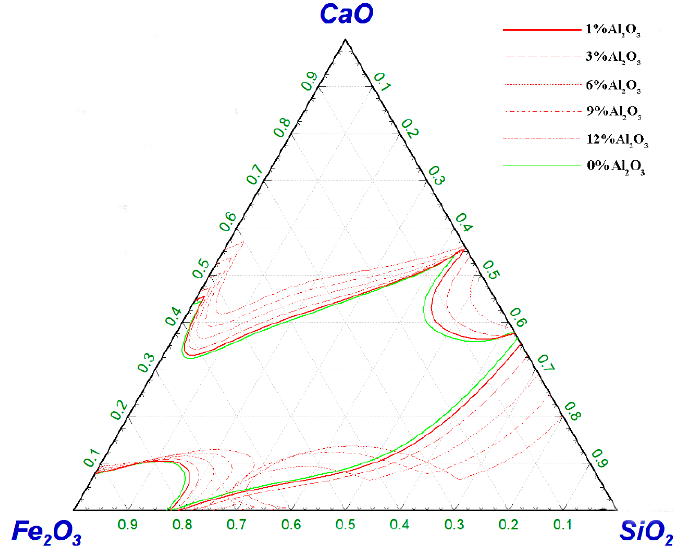
Figure 7. Effect of ω (Al 2 O 3 ) on the liquid-phase region of CaO–SiO 2 –Fe 2 O 3 slag system at 1450 °C. The pseudo-quinary phase diagram of CaO–SiO 2 –Fe 2 O 3 –Al 2 O 3 –6%MgO is shown in Figure 8. The increase in Al 2 O 3 content led to a reduction in the liquid-phase region, but it